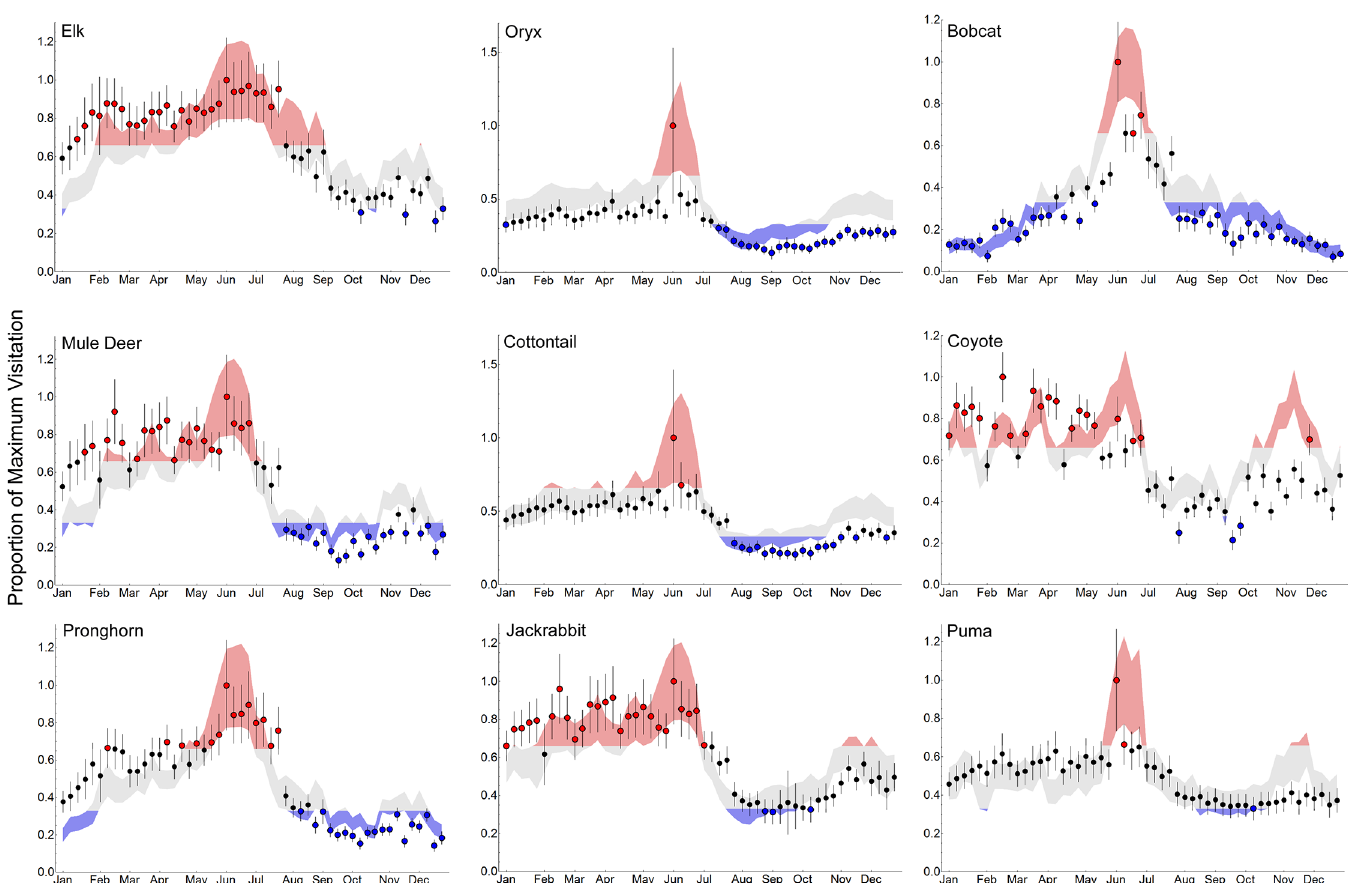
Fig 3. Monthly Timing of Visitation. Timing of visitation to water for 9 mammals inhabiting Sevilleta National Wildlife Refuge, New Mexico, USA. The shaded area encompasses the prediction and confidence interval from the best model for weekly visitation, using weather averages during the modeling period from June 29, 2009 through December 31, 2013 (and visitation by prey for carnivores). The points represent model predictions using weather data and prey visitations (as appropriate) from 2014. All predictions were divided by the maximum visitation value, to generate a proportion. Red colors values > 66.66% (high use) and blue points colors values < 33.33% (low use). Black lines on the points indicate confidence intervals. Predictions from 2014 corresponded with model predictions from 2009 – 2013.